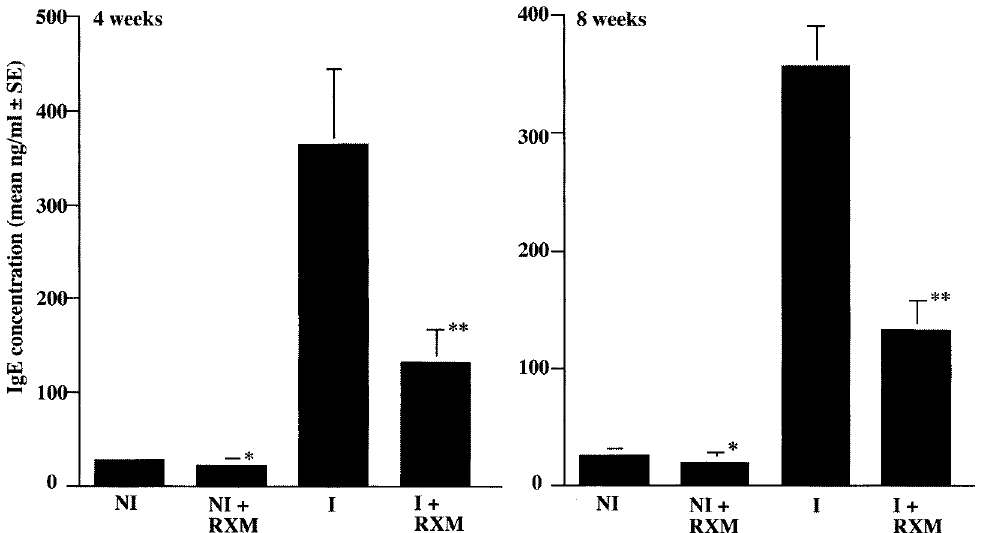
FIG. 5. Influence of oral RXM treatment on IgE production in vivo . BALB/c mice were immunized by intraperitoneal injection with 8.0 m g/ml of hemocyanin absorbed to 4.0mg of aluminum hydroxide in a volume of 0.5ml. The mice were orally administered with 2.5mg/kg of RXM once a day for 4 or 8 weeks starting 7 days after immunization. Serum IgE levels were assayed by ELISA. Data represent the mean (ng/ml) ± standard error of five individual mice. NI, Non-immunized control; I, immunized. * Not significant ( p > 0.05) as compared with control, ** significant at p < 0.001 as compared immunized